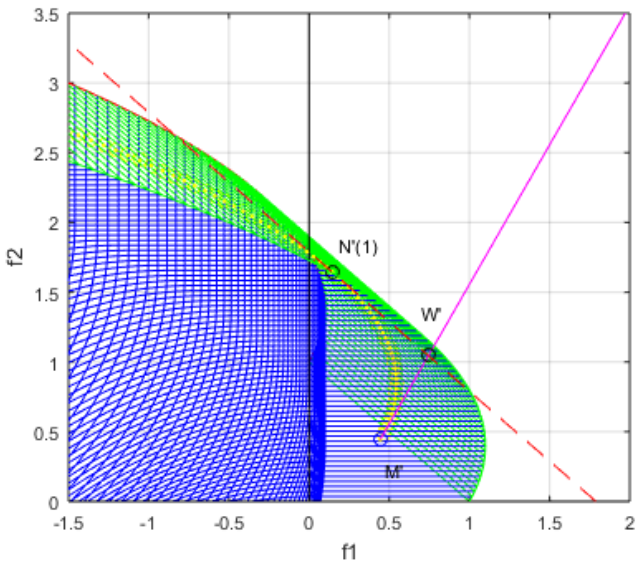
Figure 6. Sharingsolution W (cid:48)